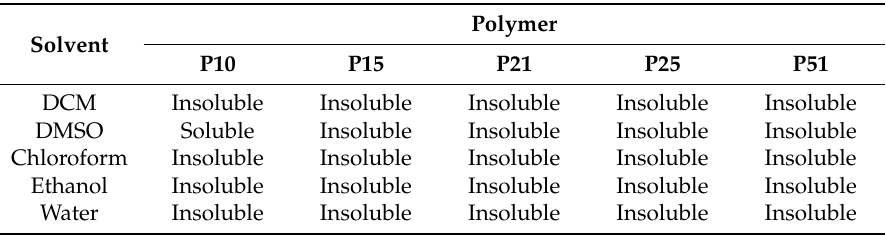
Table 3. Solubility of the synthesised